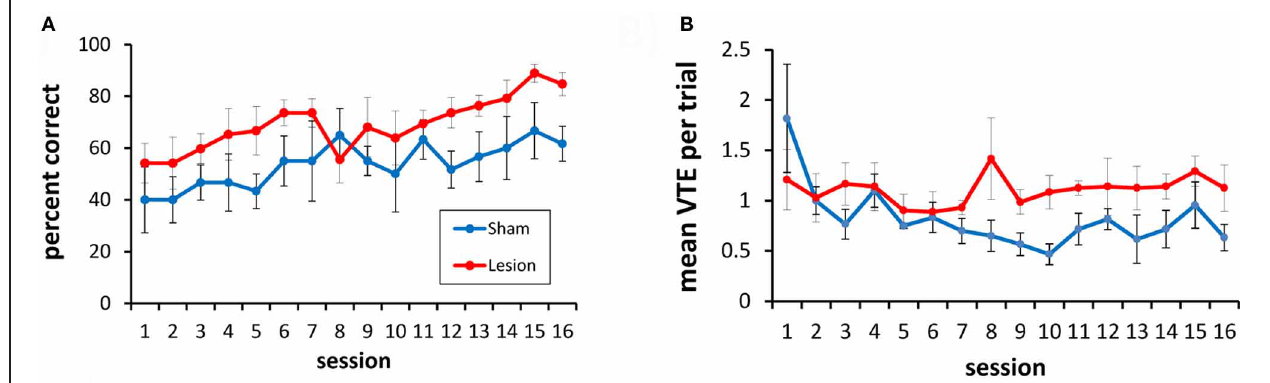
hippocampus- and the sham-lesioned animals was observed. (B) Mean VTEs per trial over the 16 sessions of testing on the three-choice discrimination.